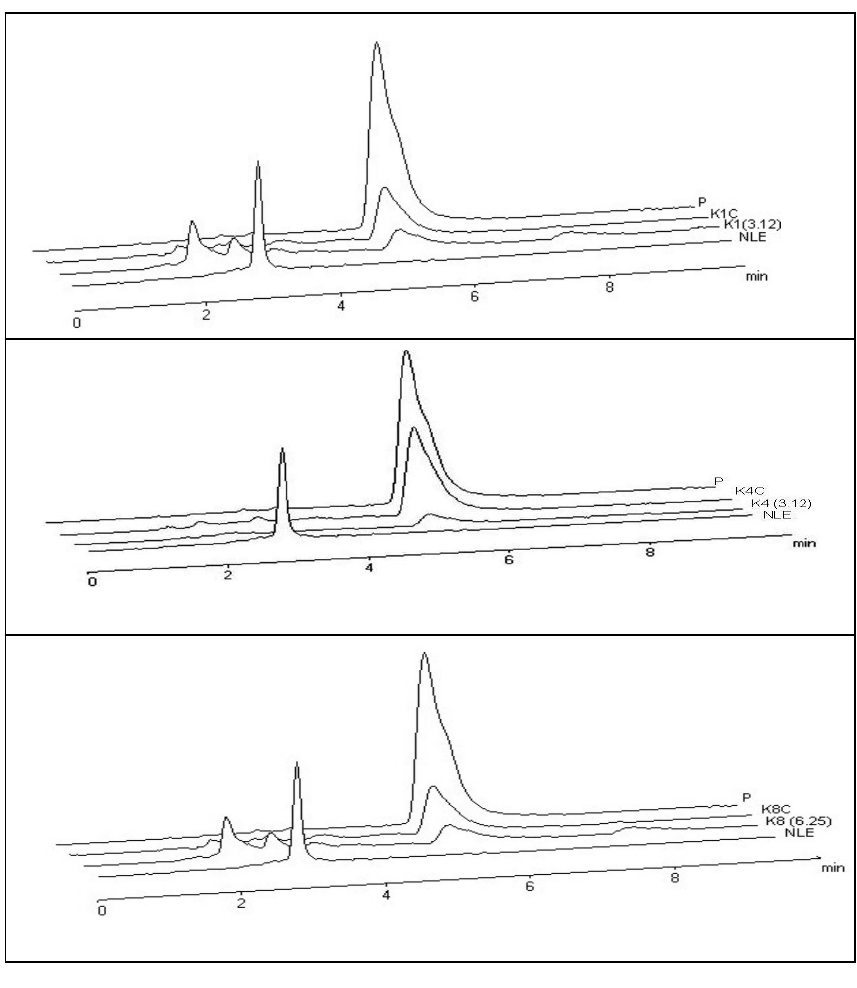
Figure 4 . HPLC elution profiles from P. citrinum isolates, as described in ‘Materials and Methods’ . (P) Citrinin standard; ( K1C ), ( K4C ), ( K8C -dil.1/5) controls of citrinin production by P. citrinum isolates grown on PD without addition of neem extract; ( K1, K4) Citrinin from P. citrinum isolates grown on PD with neem extracts (3.12 mg/mL) and ( K8) Citrinin from P. citrinum isolates grown on PD with neem extracts (6.25 mg/mL); (NLE) neem leaf extract at 12.5